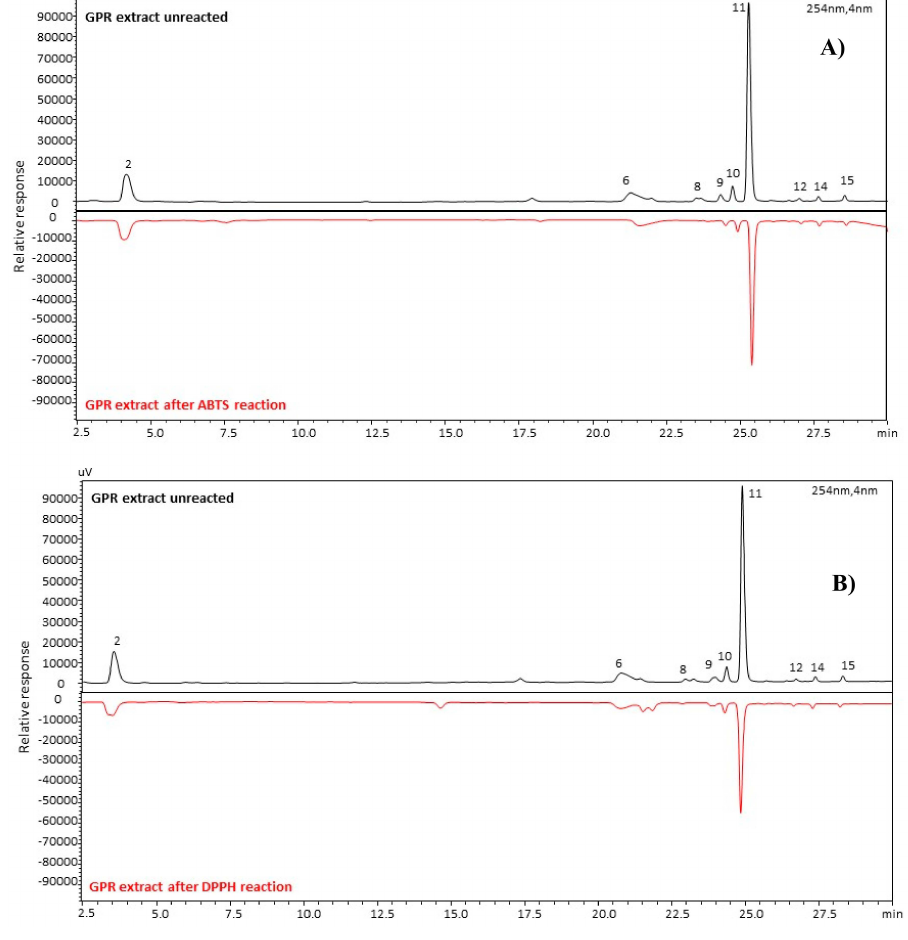
Figure 5. HPLC chromatograms of GPRs extracts before (black profile) and after (red profile) reaction with ABTS ( A ) and DPPH ( B ) free radical. For peak numbers, see Table